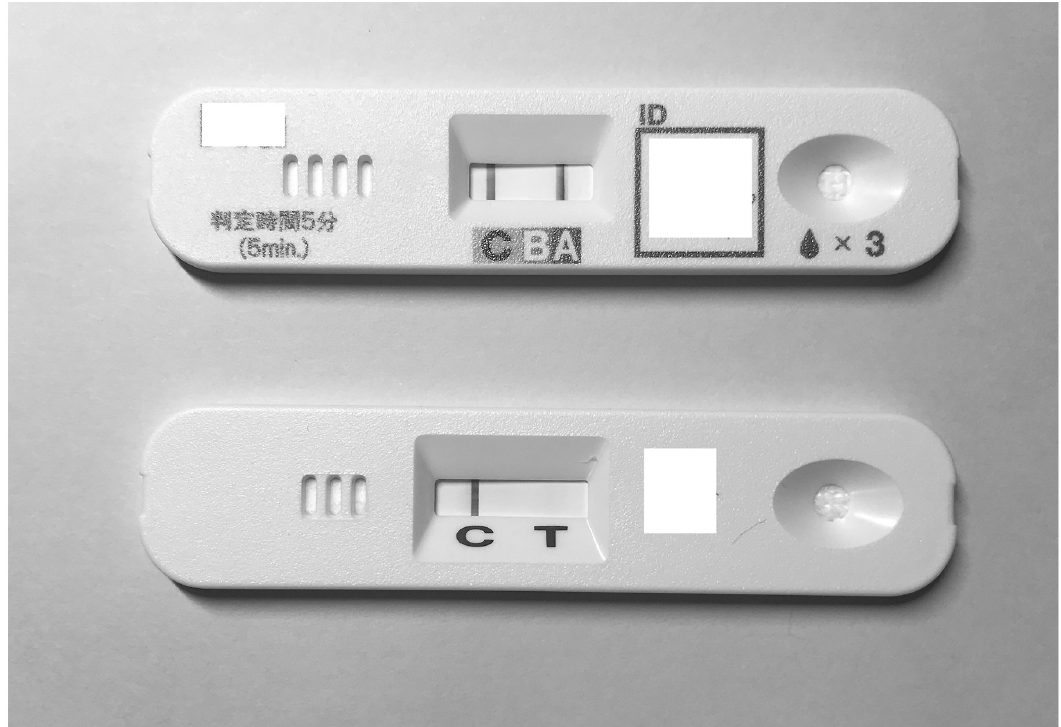
Fig 2. The patient was diagnosed with influenza A/H3N2 infection because he was positive for influenza A by ImunoAce Flu (upper) but negative by Linjudge FluA/pdm (lower).